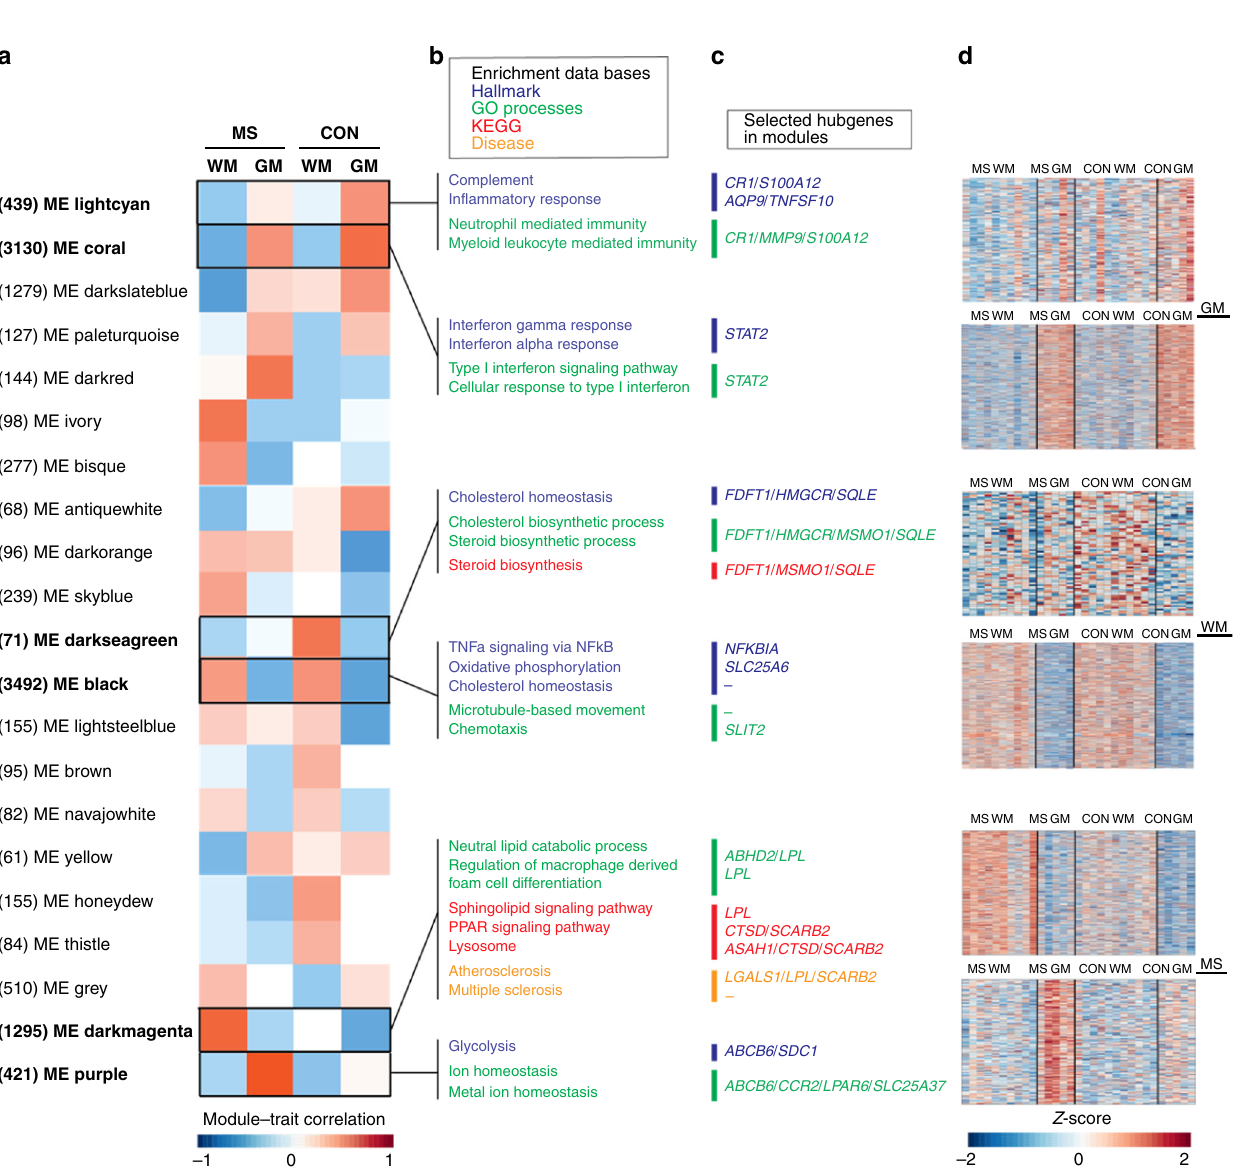
(Fig. 3c). High interdonor variation in gene expression patterns for WM control microglia was observed (Fig. 3d). Within ME black, corresponding to WM microglia in both control and MS tissue, top enriched hallmark pathways were “ TNF α signaling